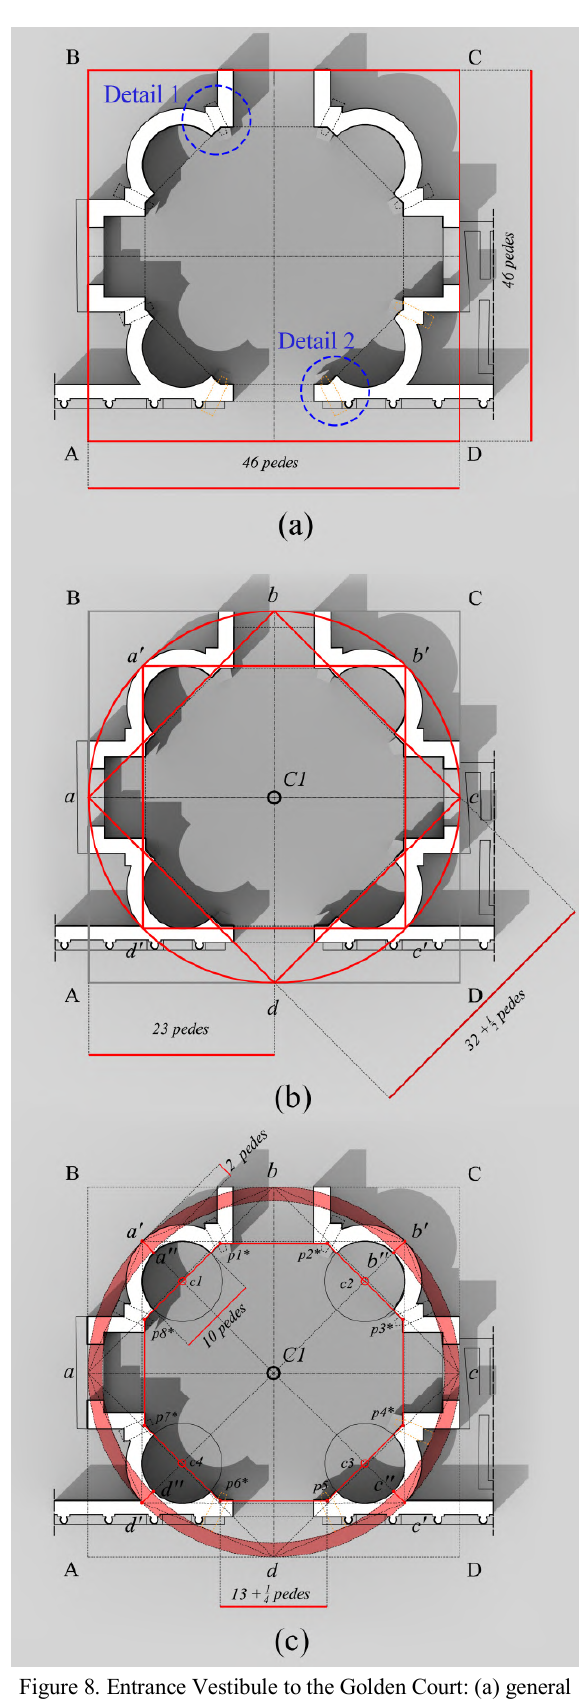
Figure 8. Entrance Vestibule to the Golden Court: (a) general dimensioning; (b) definition of the layout; (c) walls’ dimensioning